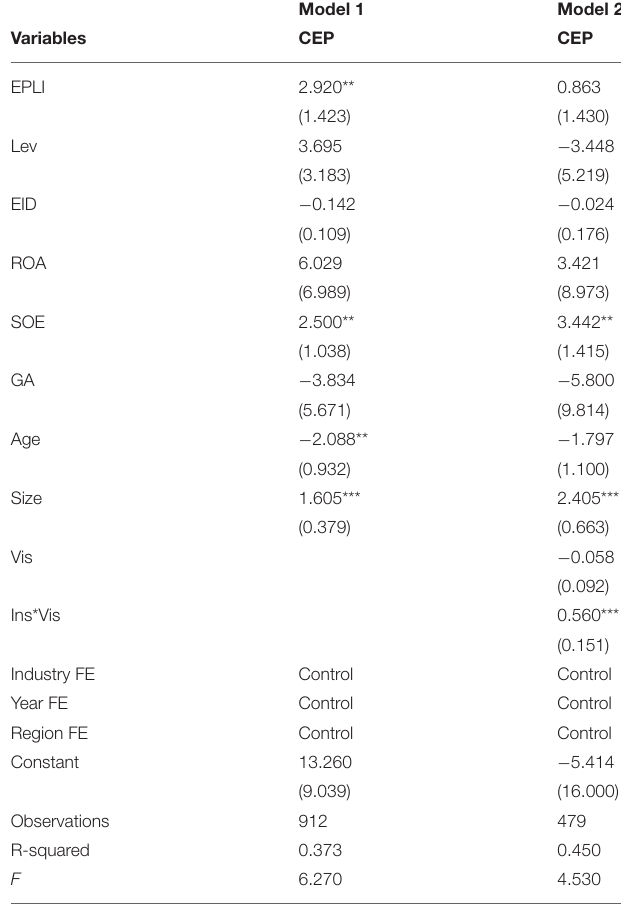
TABLE 4 | Model regression results